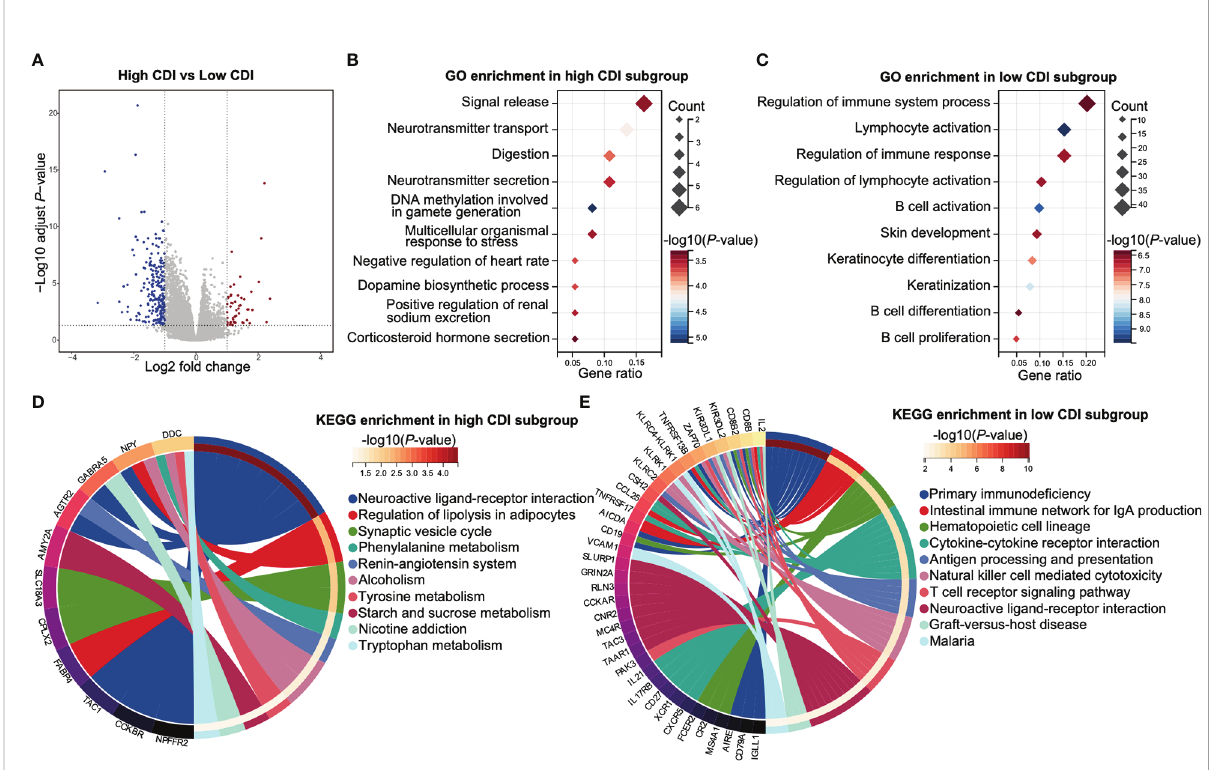
FIGURE 5 Functional enrichments of HPV negative HNSCC patients with different CDI scores. (A) A volcano plot of differentially expressed genes between the subgroups of different CDI scores of HPV negative HNSCC. (B, C) The top 10 enriched GO biological processes of up-regulated genes in high CDI subgroup (B) and low CDI subgroup (C) . (D, E) The top 10 enriched KEGG pathways of up-regulated genes in high CDI subgroup (D) and low CDI subgroup (E) . HNSCC: head and neck squamous cell carcinoma; CDI: cell death index; HPV: human papillomavirus; GO: Gene Ontology; KEGG: Kyoto Encyclopedia of Genes and